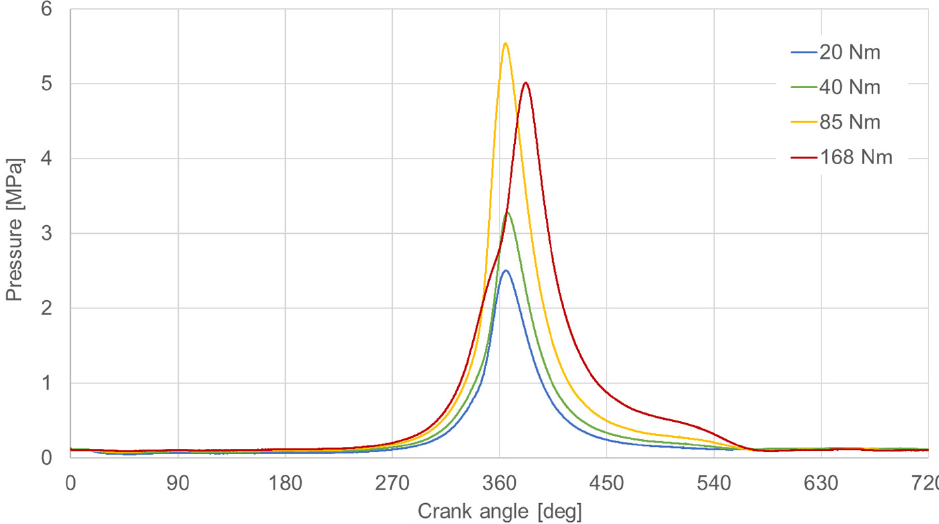
Figure 3. Indicated pressure for different engine loads.